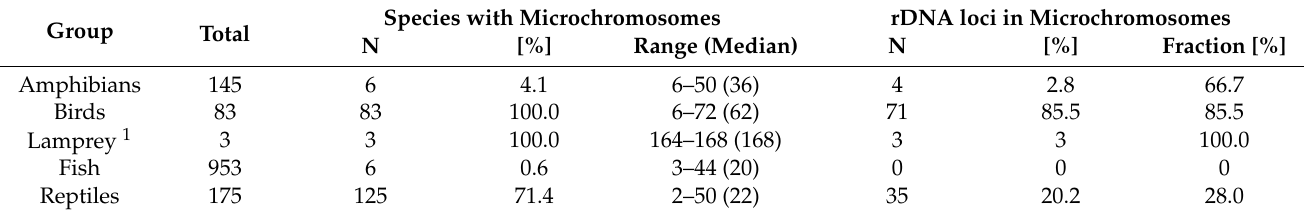
Table 4. Frequency of 45S rDNA localization in